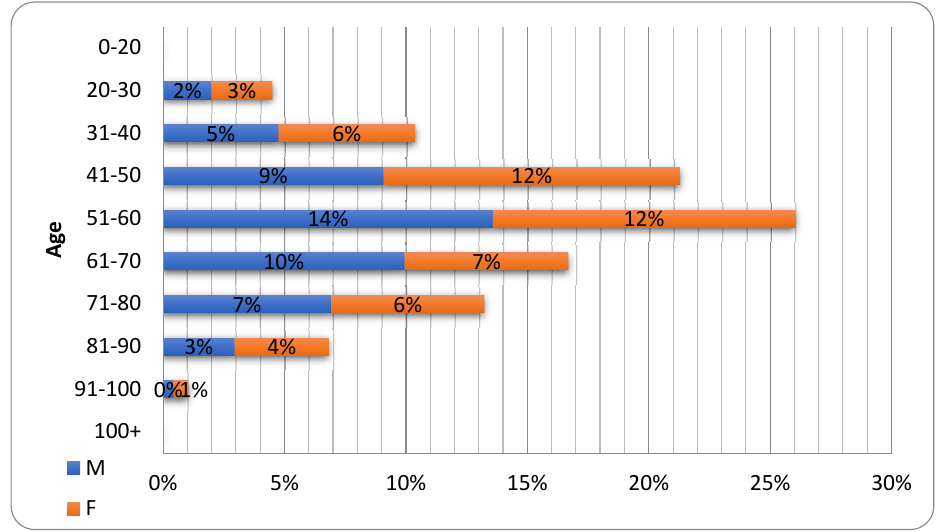
Figure 2. Patient distribution by age and gender.